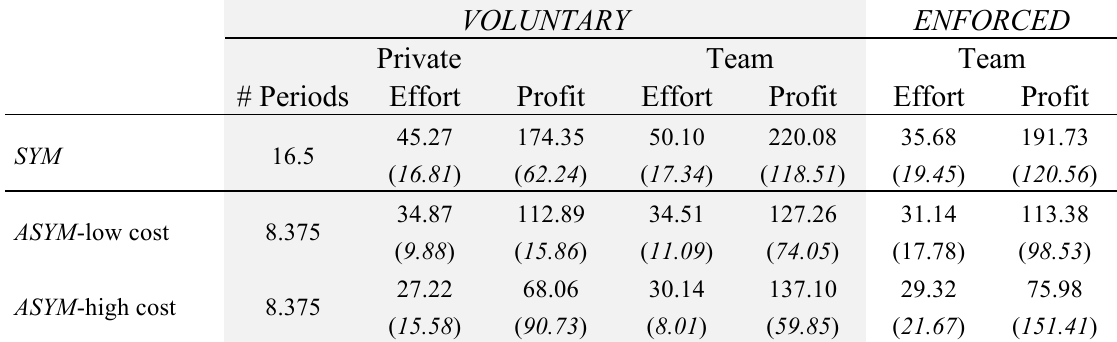
Table 2. Average effort and profit levels (standard deviation in